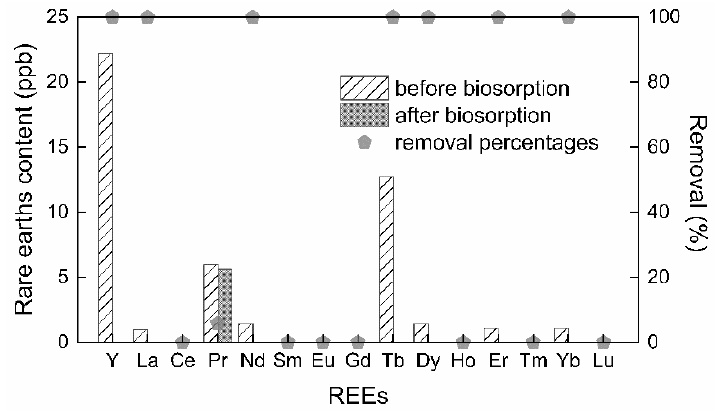
Figure 2. The content of REEs in soil leaching solution of rare earth mining area before and after the biosorption by PS4150